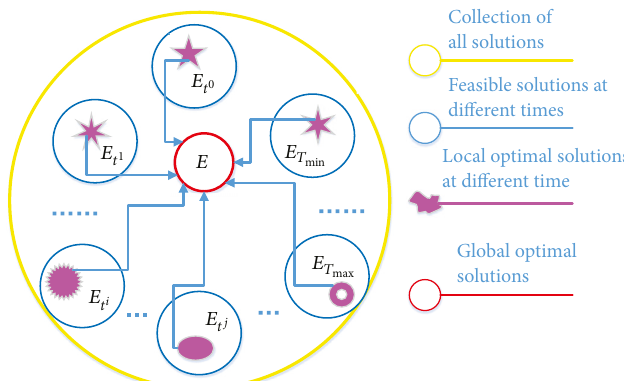
Figure 11: Distribution of solutions.